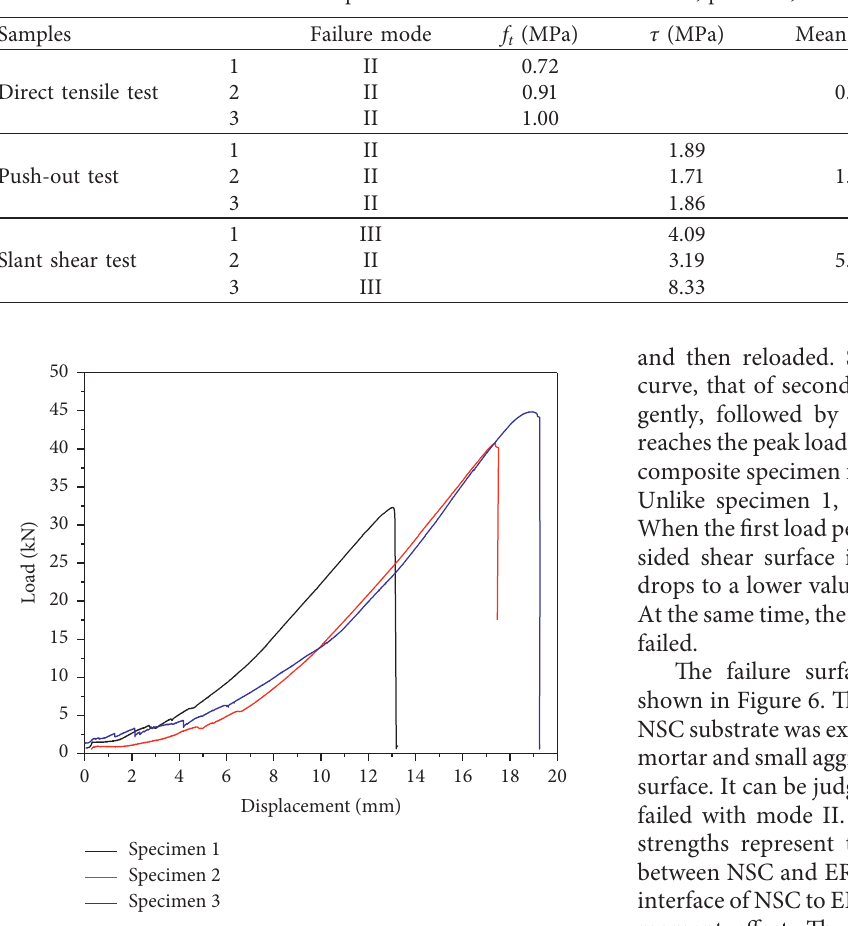
Figure 3: The direct tensile test specimen load-displacement